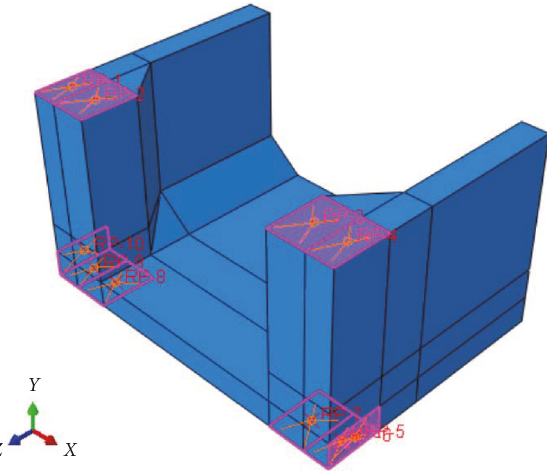
Figure 14: Design of the simple